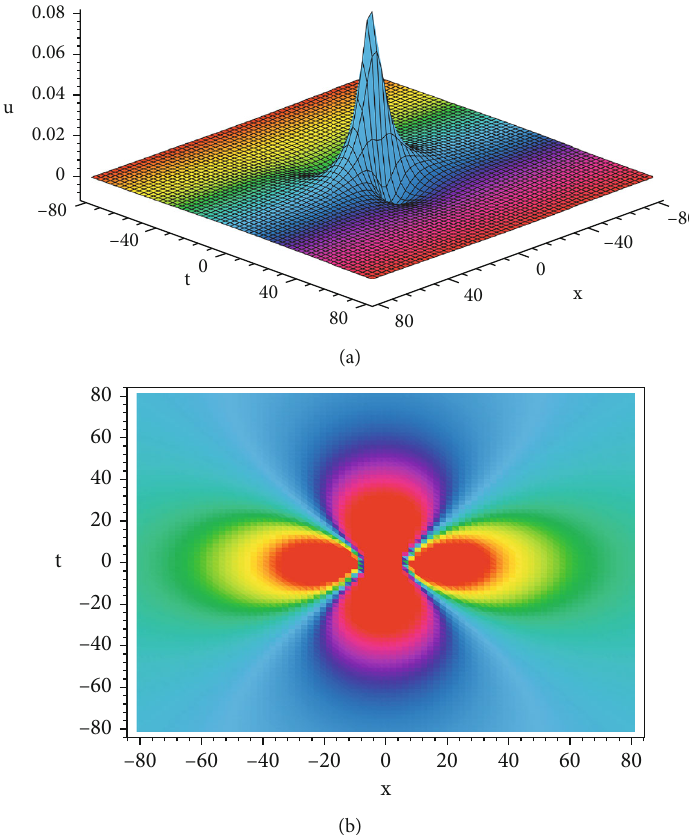
Figure 3: (a) The three-dimensional plot of a lump wave of the higher-order Boussinesq equation with the parameters (21). (b) The corresponding density